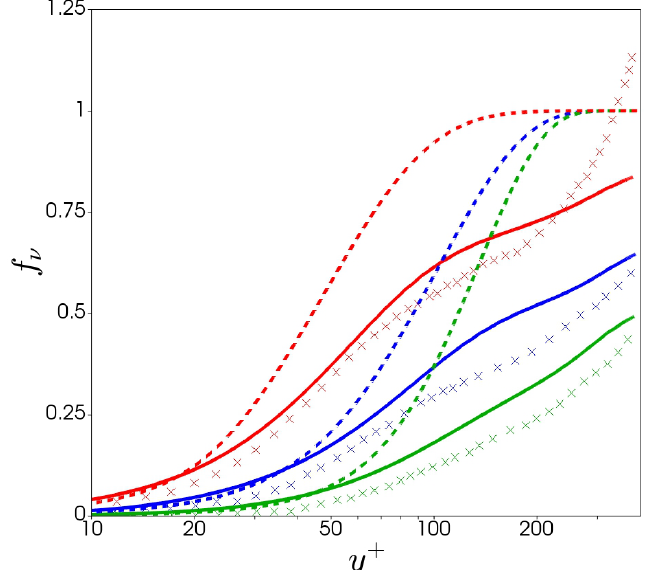
Figure 2. Comparison of the f ν model between DNS data ( × crosses) and predictions with the new model (continuum lines), and previous model (dash lines): each colour represents a different drag reduction regime: red (low drag reduction (LDR), case 16); blue (intermediate drag reduction (IDR), case 19); green (high drag reduction (HDR), case